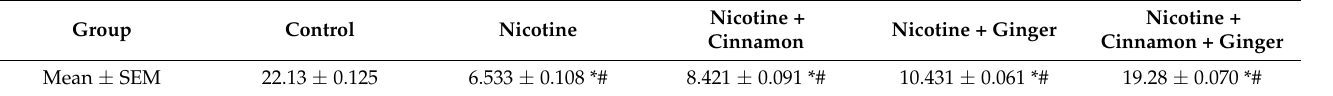
Figure 1. A, B: Brain oxidative stress markers ( 1A ) MDA concentration (nmol/g brain tissue), ( 1B ) glutathione (GSH) (mmol/brain tissue). * significantly different from the control group; # significantly different from other group p value = 0.05. Table 2. GSH level in mmol/gm in the brain tissue of the different